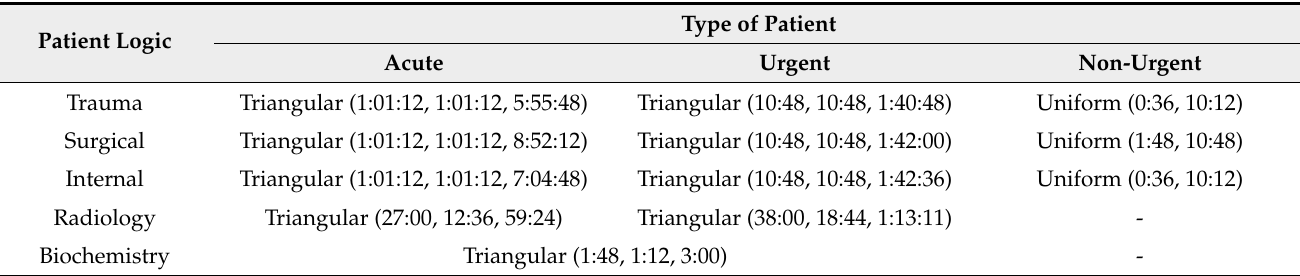
Table 1. Duration of treatment at each workplace. Type of Patient Patient Logic Acute Urgent